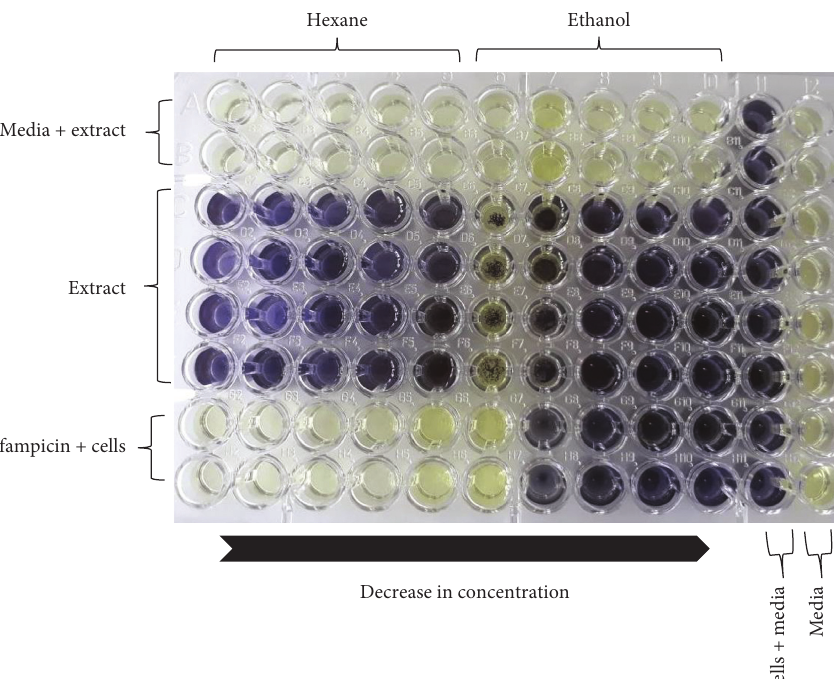
Figure 1: A typical microbroth dilution assay showing MTT results after subculture of M. smegmatis with control drug rifampicin and hexane and ethanol pod extracts of P. thonningii. Viable M. smegmatis cells reduced yellow MTTdye to blue. This indicated that there was no inhibition of M. smegmatis in wells with blue colour. Column 11 represents cells only well (positive control). Column 12 containing media only remained yellow. Thus, no contamination of media occurred. The top two rows A and B remained yellow, where extract and media were checked for